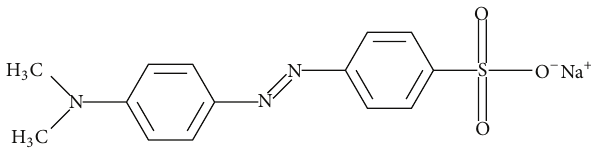
Figure 1: Chemical structure of methyl